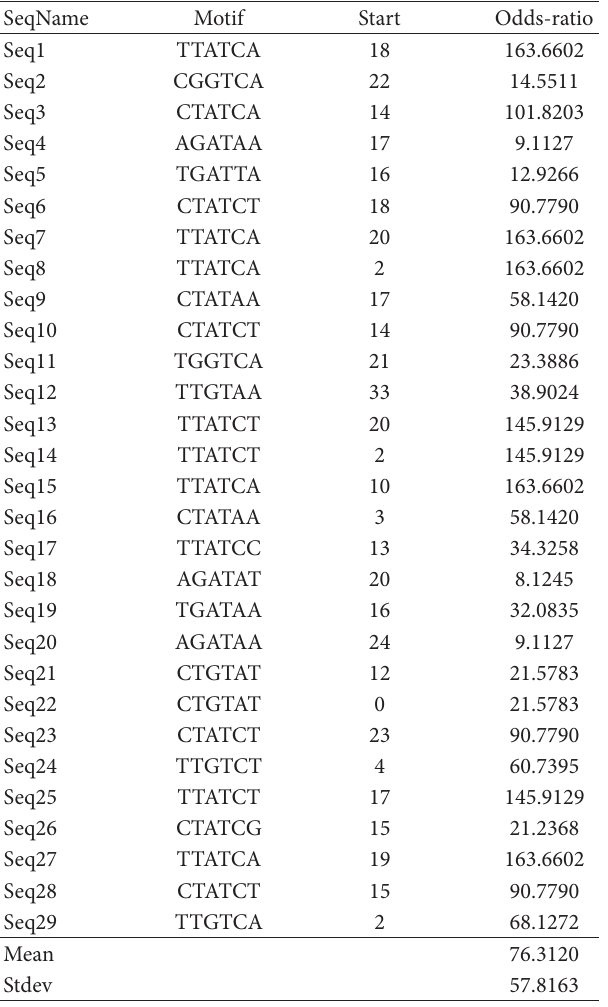
T 7: Output of PWMS as a quantitative measure of the